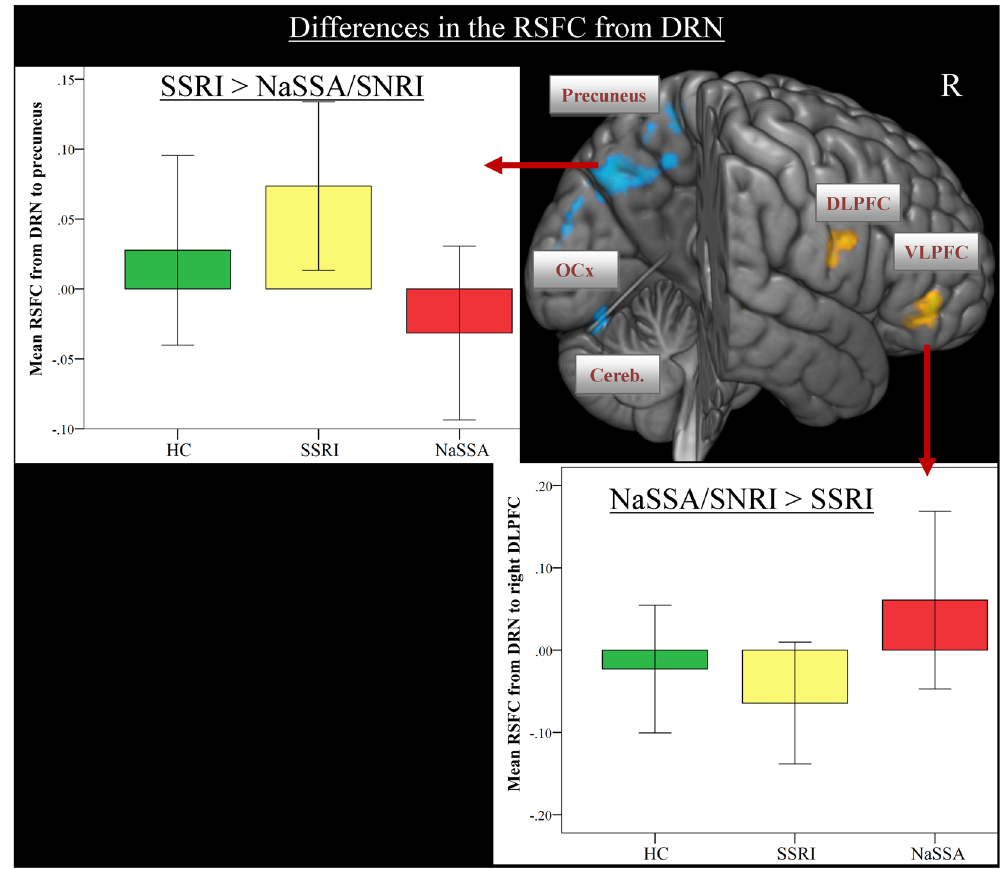
Figure 3. Differences between the classes of antidepressant medication in the whole-brain resting-state functional connectivity maps with seed region in the dorsal raphe nucleus (DRN). Depressed patients with an SSRI demonstrated stronger FC from DRN to the posterior brain regions in contrast to patients taking an SNRI/NaSSA (blue color). In the opposite contrast, patients with an SNRI/NaSSA showed stronger FC to the right DLPF and VLPFC (yellow color). Abbr.: SSRI, selective serotonin re-uptake inhibitor; SNRI, serotonin and noradrenalin reuptake inhibitor; NaSSA, noradrenergic and specific serotonergic antidepressant; DLPFC, dorsolateral prefrontal cortex; VLPFC, ventrolateral prefrontal cortex; OCx, occipital cortex; Cereb.,